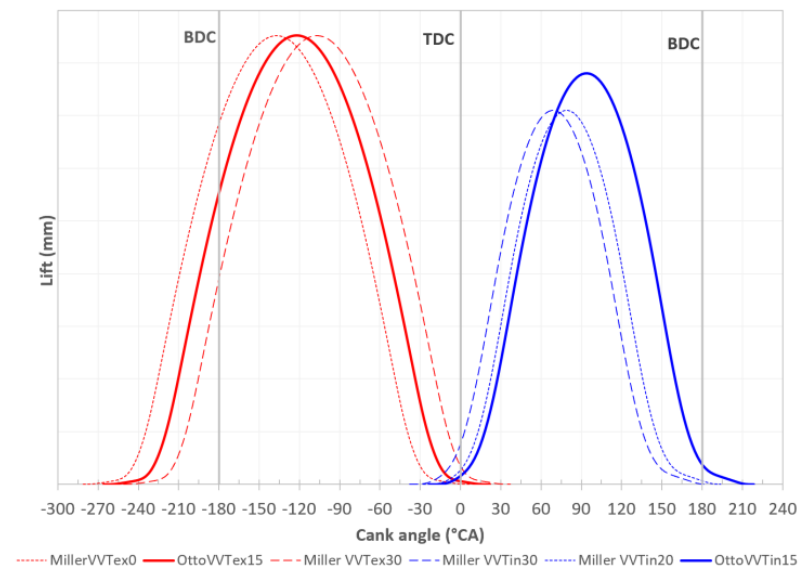
Figure 2. Exhaust and intake events: valve lift laws.